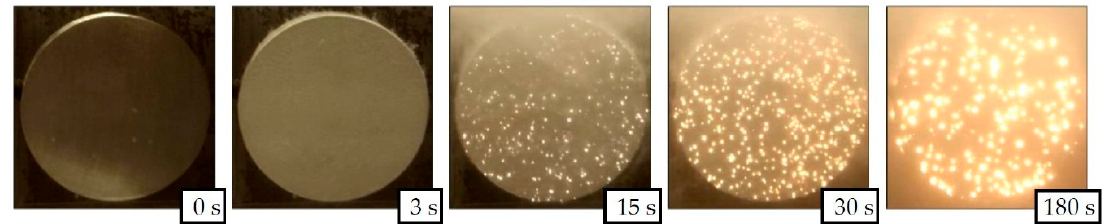
Figure 2. Evolution of discharge distribution and intensity in relation to the process time for the PEO of an AZ31 magnesium alloy in an alkaline silicate electrolyte. Brightness correlates with discharge intensity on the respective surface region of the sample.